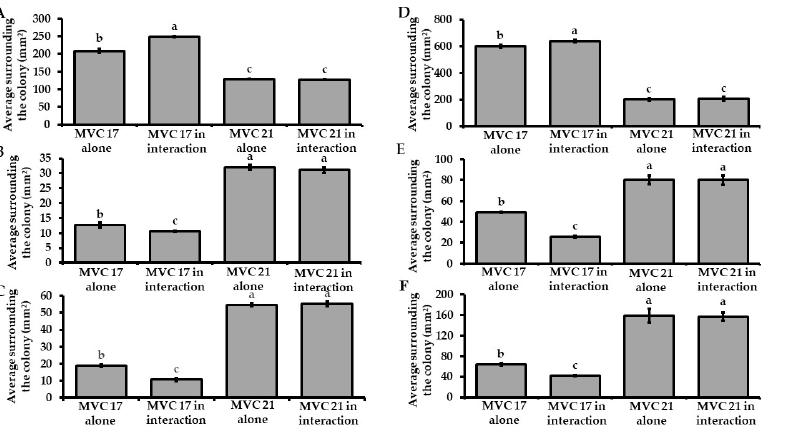
Figure 1. Effect of bacterial interaction on plant growth-promoting activities. Assessment of the ability of Pantoea agglomerans MVC 21 and Pseudomonas ( Ps .) putida MVC 17 to release siderophores ( A , D ) and to solubilise phosphate ( B , E ) and potassium ( C , F ) during the interaction in not split ( A – C ) and split Petri ( D – F ) dishes. MVC 17 alone. halo size of Ps. putida MVC 17 grown alone; MVC 17 in interaction. Halo size of Ps. putida MVC 17 interacting with P. agglomerans MVC 21; MVC 21 alone. halo size of P. agglomerans MVC 21 grown alone; MVC 21 in interaction. Halo size of P. agglomerans MVC 21 interacting with Ps. putida MVC 17. Columns represent mean standard error of six replicates (Petri dishes) are reported for each treatment. Data from two independent experiments were pooled. Different letters indicate significant differences among treatments according to Tukey´s test ( α = 0.05).